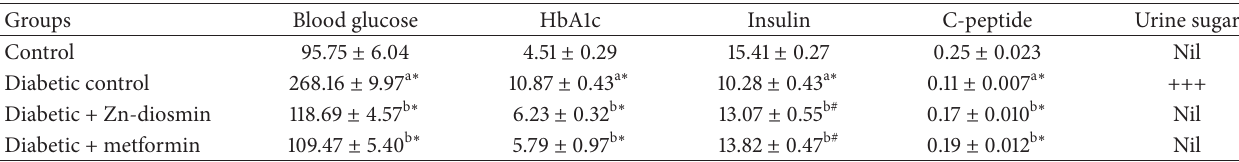
Table 1: The levels of blood glucose, glycosylated hemoglobin (HbA1c), plasma insulin, and urine sugar in control and experimental groups of rats.